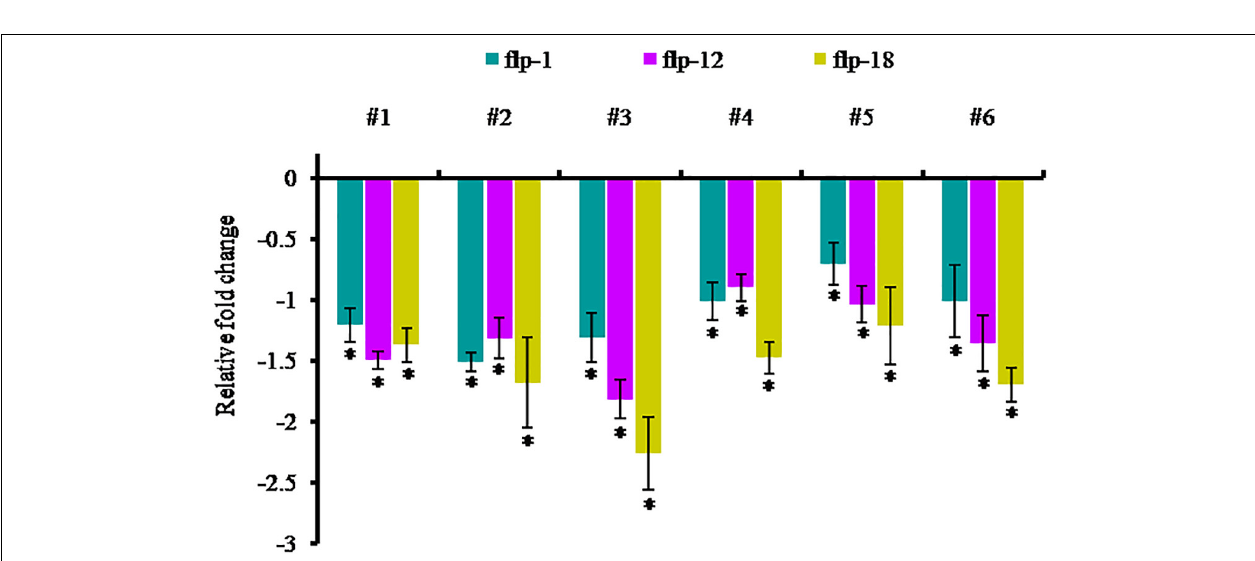
FIGURE 9 | Transcript levels of Mi-flp1, Mi-flp12 , and Mi-flp18 in M. incognita females extracted from dsRNA expressing transgenic events ( #1 to #6 : 25-6, 27-4, 28-9, 36-12, 38-5, and 47-2). Expression was measured as relative fold-change, analyzed using 2 - (cid:49) (cid:49) CT method. Each bar represents the mean ± SE of n = 3, and asterisks specify the significant difference at P <